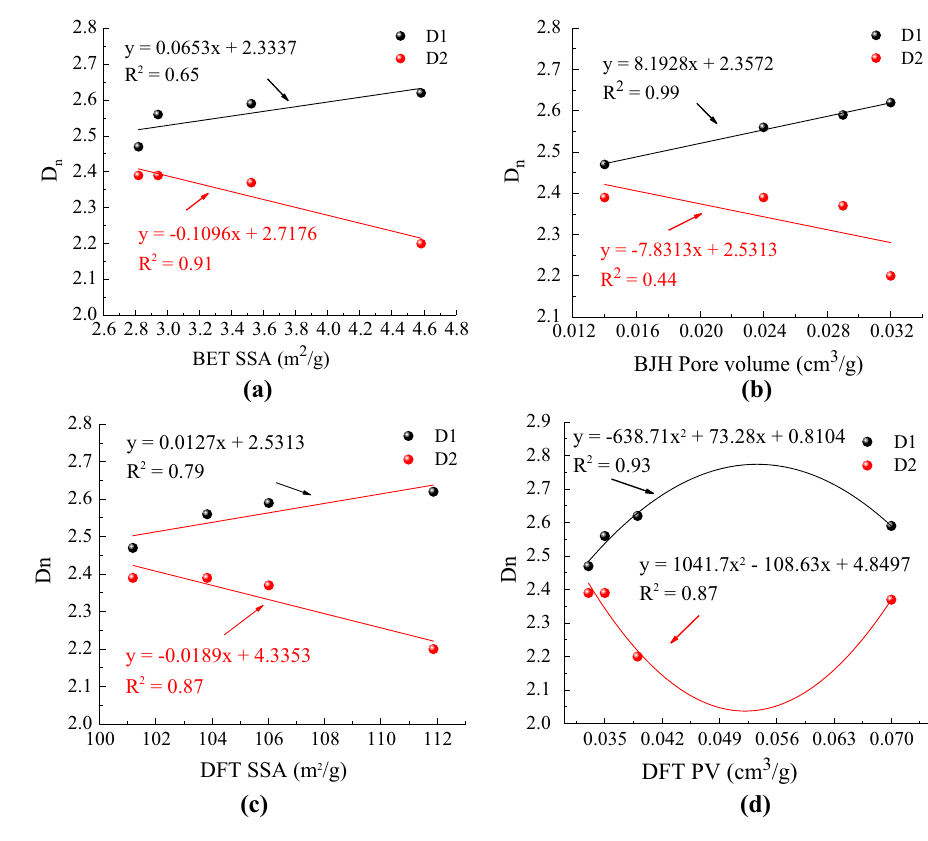
Fig. 8 a Correlation of fractal dimensions with BET-SSA; b Correlation of fractal dimen- sions with BJH pore volume; c Correlation of fractal dimen- sions with DFT-SSA; and d Correlation of fractal dimen- sions with DFT pore volume